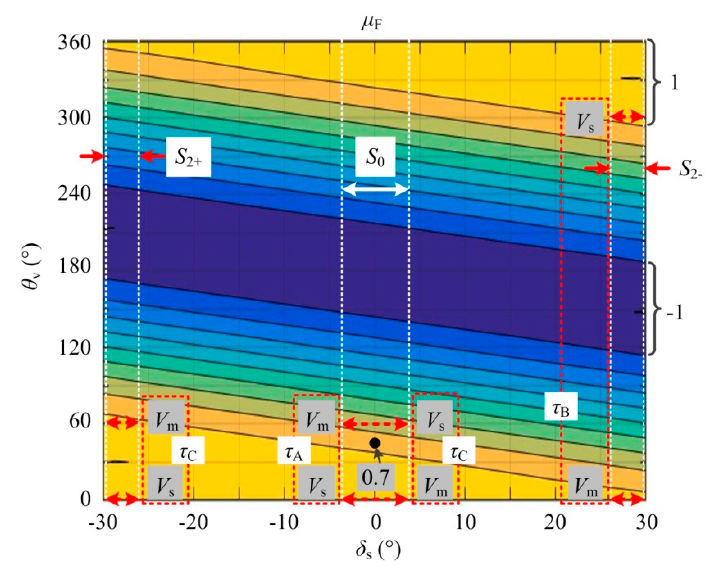
Figure 9. Two-dimensional contour map of flux error active factors.